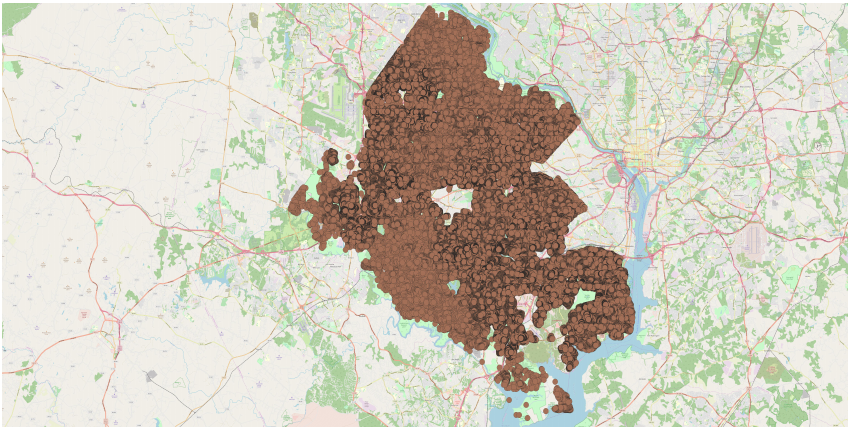
Figure 15. A weighted overlay analysis for data points plotted over the Open Street map.